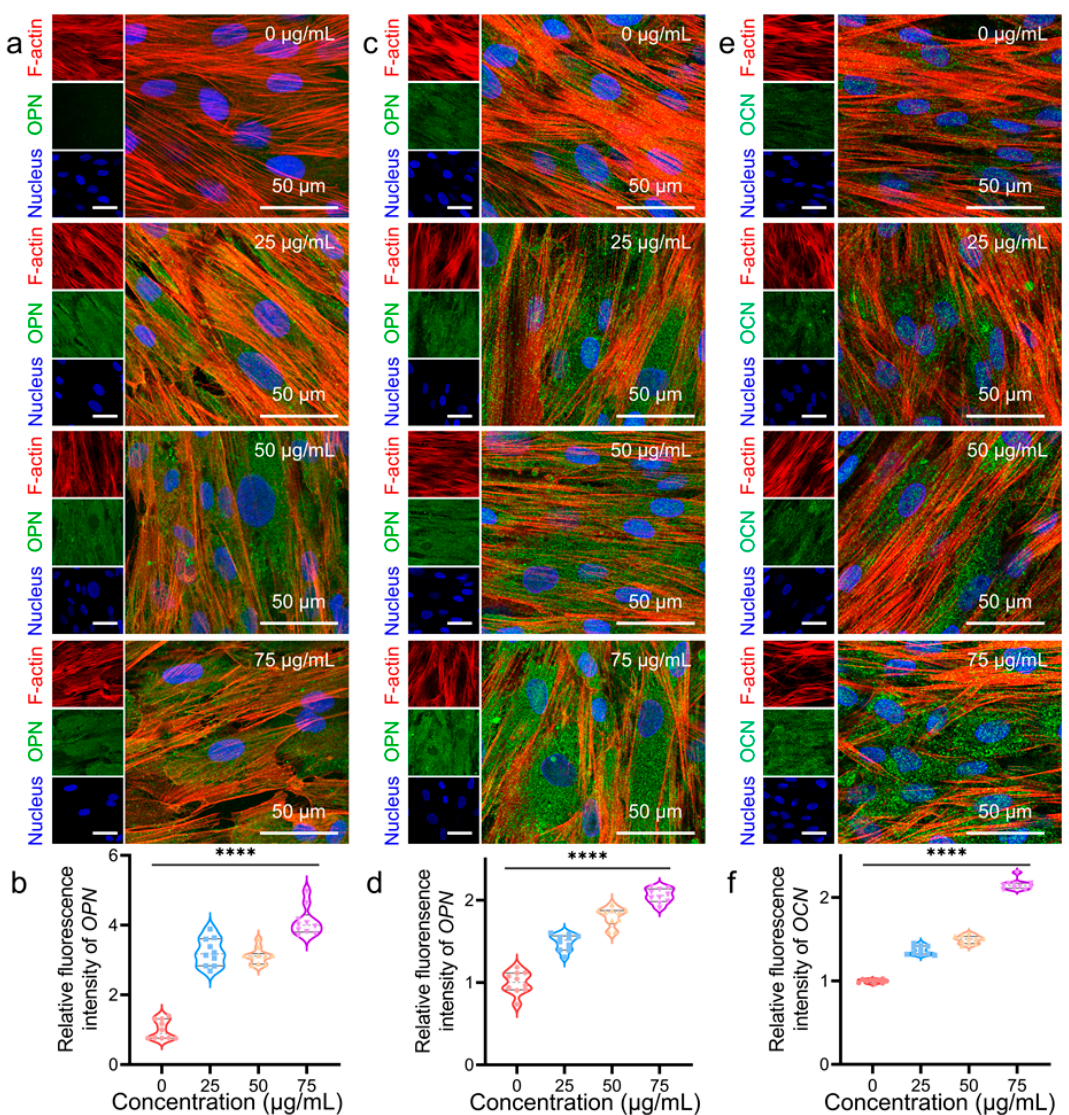
Figure 5. Immunofluorescence staining of OPN and OCN protein. ( a ) OPN (green), F-actin (red), and nuclear (blue) staining images for 7 days. ( b ) Quantitative analysis of the mean fluorescence intensity of immunofluorescence-stained images of OPN expression at 7 days. ( c ) OPN (green), F-actin (red), and nuclear (blue) staining images for 14 days. ( d ) Quantitative analysis of the mean fluorescence intensity of immunofluorescence-stained images of OPN expression at 14 days. ( e ) OCN (green), F-actin (red), and nucleus (blue) staining images for 14 days. ( f ) Quantitative analysis of the mean fluorescence intensity of immunofluorescence-stained images of OCN expression at 14 days. Data represent mean ± standard deviation ( n = 10). Significance was determined by one-way ANOVA (**** p < 0.0001, vs. the 0 μ g/mL group). Apart from the expression of osteoblast-related genes and proteins, osteogenic dif- ferentiation of stem cells can also be identified by detecting the biological markers of os- teoblasts (Figure 6). Osteogenesis differentiation at the early stage can be determined by ALP, which acts as an extracellular enzyme for osteoblasts that directly reflects the activity or functional status of osteoblasts [38]. The following stage can be evaluated by analyzing the mineralization of the extracellular matrix [39]. The hydrolysate of 5-bromo-4-chloro- 3-indolyl-phosphate (BCIP) and nitro-blue tetrazolium (NBT) was used to perform ALP staining as blue. After culturing with 0, 25, 50, and 75 μ g/mL MNPs for 7 days, the color